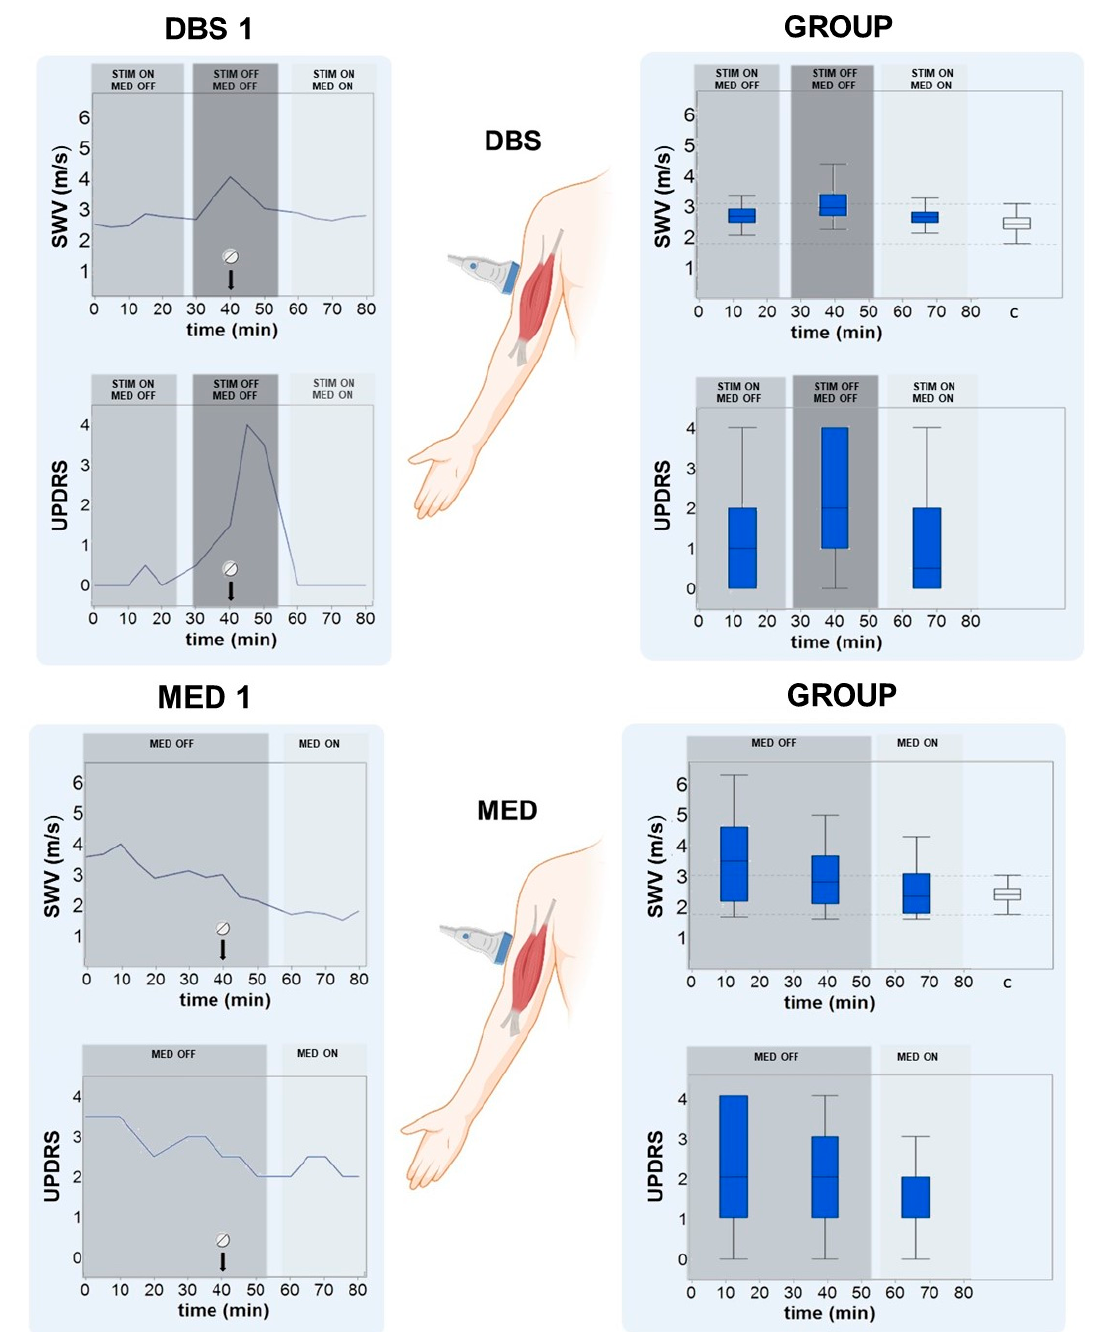
Figure 4. Shear wave velocity (SWV) and Movement Disorder Society Unified Parkinson’s Disease Rating Scale (MDS-UPDRS) in the biceps brachii (BB) muscle in passive extension in deep brain stimulation (DBS) and medication-only patients. The SWV and MDS-UPDRS-III item 22b-c were recorded in 5 min intervals longitudinally over a total period of 80 min. DBS was turned on and off (DBS ON/OFF). Regular levodopa with benserazide or carbidopa was timed to the 40th minute of the measurement to include the therapeutic effect of levodopa (MED ON/OFF). ( Left ): individual measurements of one exemplary patient with DBS (DBS1). ( Right ): group comparisons. It becomes evident that SWV and MDS-UPDRS rose and fell with various therapeutic conditions and correlated positively. The comparisons between different timepoints were statistically significant ( p < 0.001). Boxplots on the far right labeled with ‘c´, with SWE measurements from healthy controls as a reference, were included.